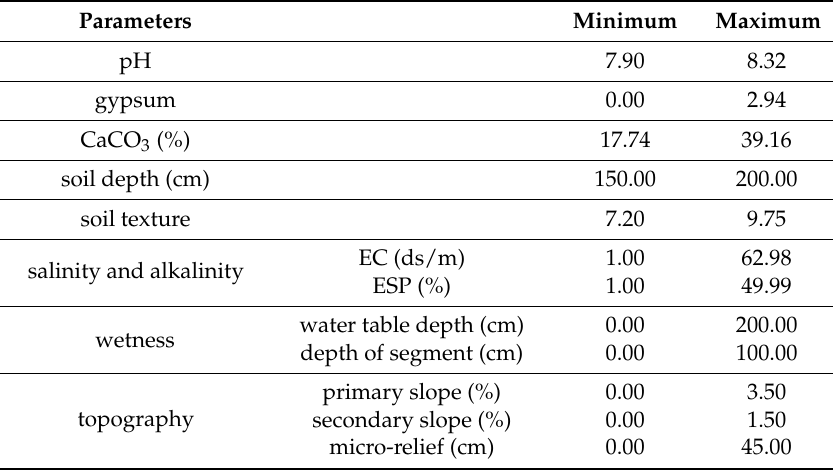
Table 1. Summary of parameters for land suitability classification in the study area.